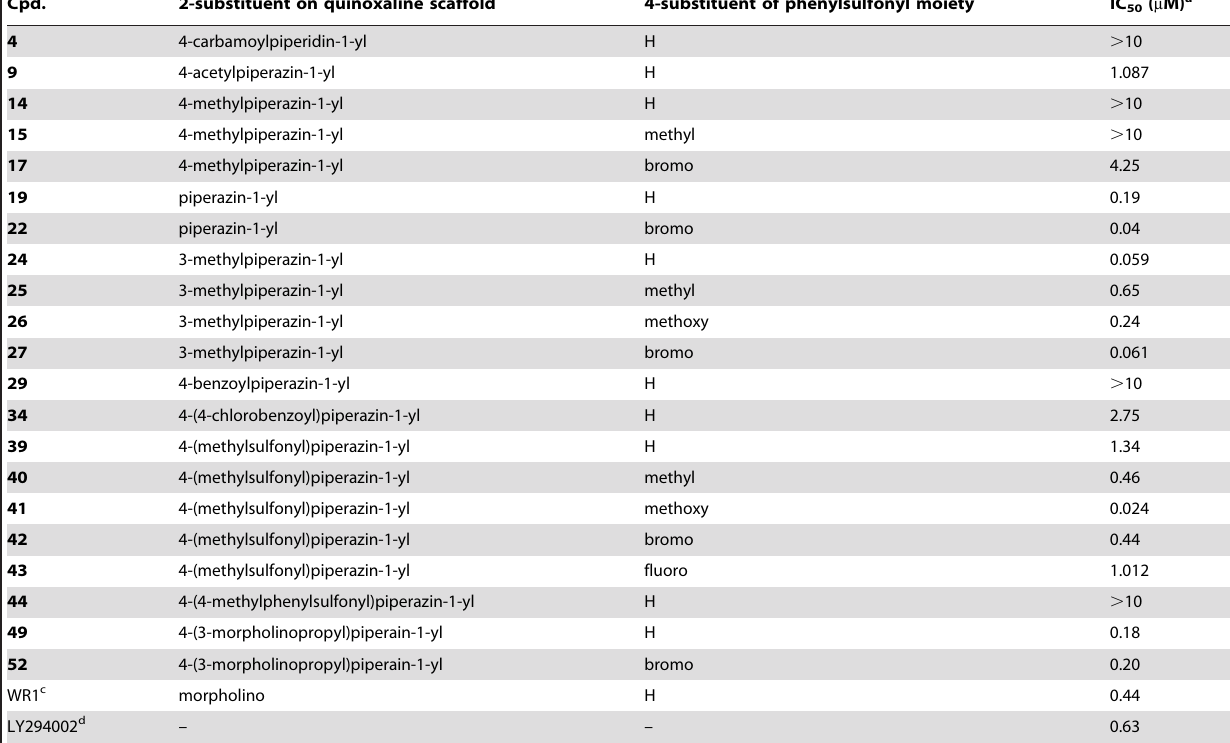
Table 4. PI3K a inhibitory activity of target compounds.